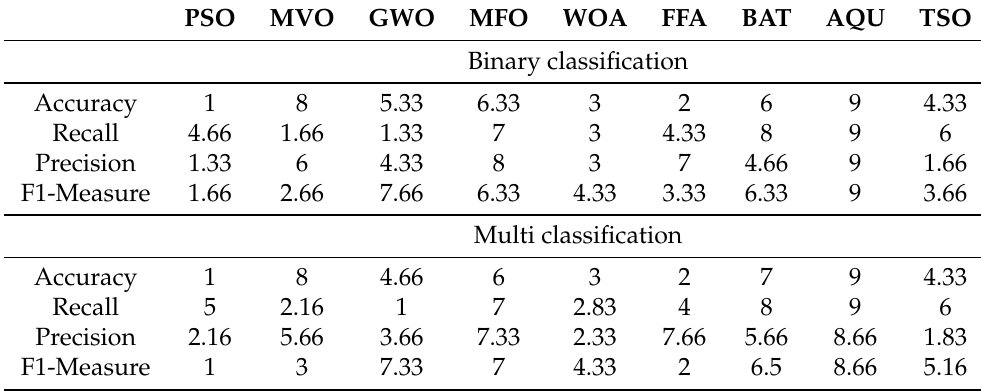
Table 4. Results of algorithms using Friedman test.